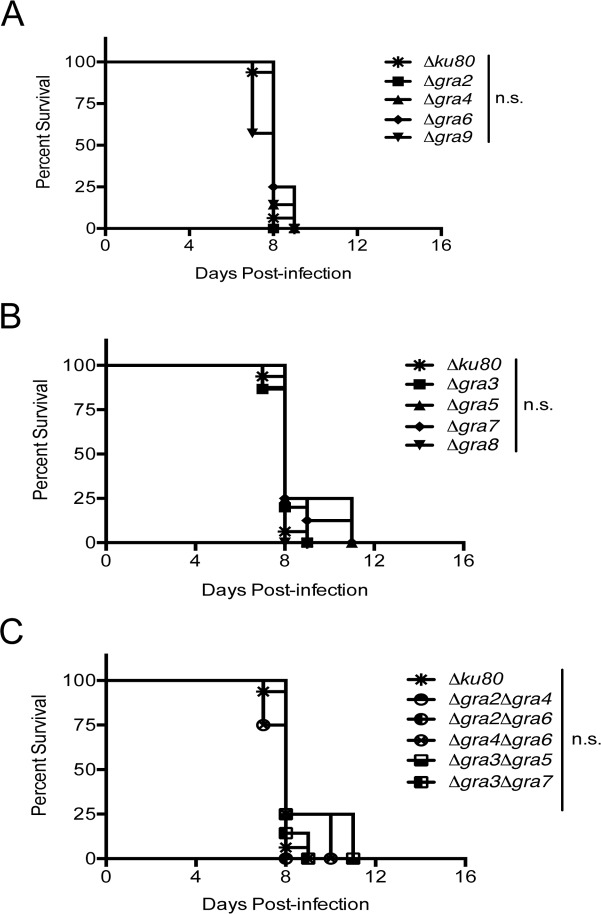
Virulence of single and double GRA knockout strains in CD1 mice.One hundred tachyzoites of the parental (Δku80) or knockout (Δgra) strains were injected intraperitoneally (i.p.) into 8 week old female CD1 mice and survival was followed for 30 days (n = 8 for Δgra3, Δgra4, Δgra7, Δgra9, Δgra3Δgra5 and Δgra3Δgra7, n = 4 for Δgra2, Δgra5, Δgra6, Δgra8, Δgra2Δgra4, Δgra2Δgra6, and Δgra4Δgra6). A) Survival of mice infected with parasites containing single GRA knockouts for IVN-localized GRA proteins. B) Survival of mice infected with parasites containing single GRA knockouts for PVM-localized GRA proteins. C) Survival of mice infected with parasites containing double GRA knockouts. Significance was determined by a Student’s t-test comparing the knockout strain with the parental.